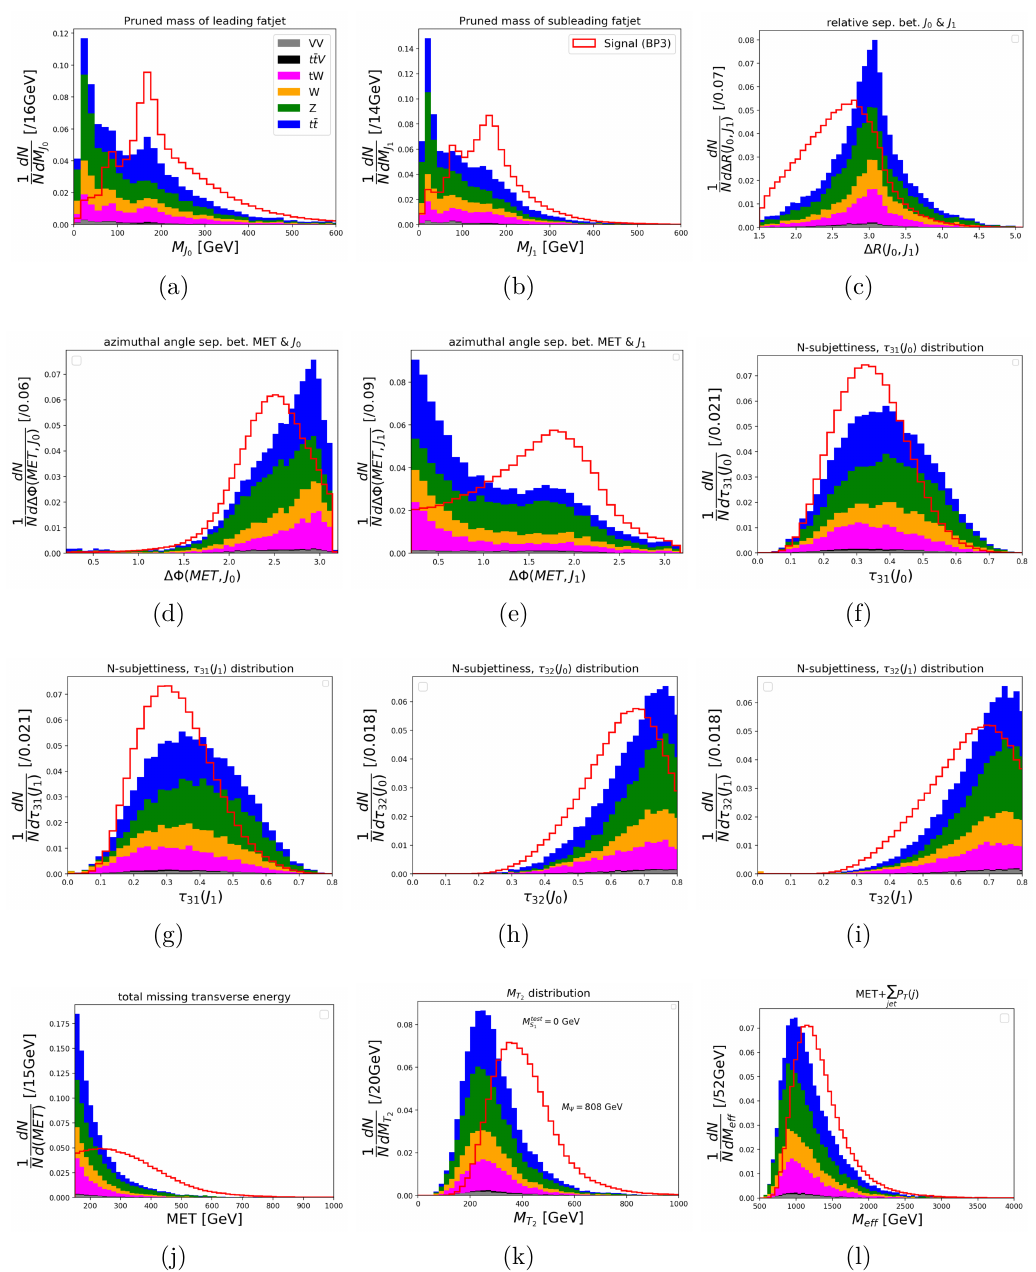
Figure 6. Distributions of different kinematical variables for the signal (BP3) and all the back- grounds contributing to the fatjets + /E final state after imposing the b tag within leading or T subleading fatjet, /E > 150 GeV, and the primary event selection criteria (described in the text) T for 14 TeV LHC. The normalized distribution for the signal is given by the solid red line. The events of each background process have been weighted by their cross-section and the cut efficiency after applying the previously mentioned cuts. Each background process is then normalized to the sum of individual cross-section times cut efficiency. Colors show the contribution of the individual background